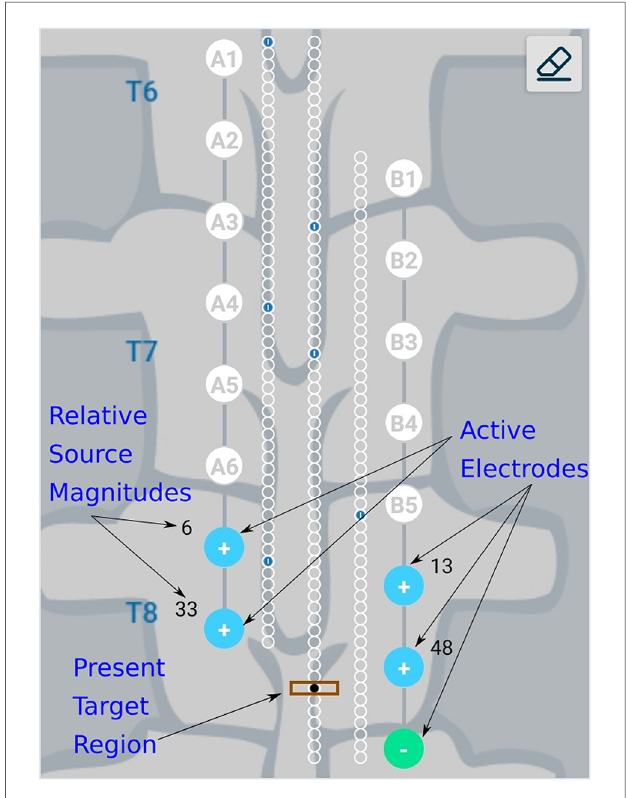
FIGURE 5 Schematic representation of user interface. Green, fi lled circles indicate current sinks and blue, fi lled circles indicate current sources. The numbers near the electrodes represent the relative percentage of current sourced/sunk through the electrodes. Small blue circles with a dash inside them represent target locations which have already been checked by the clinician.